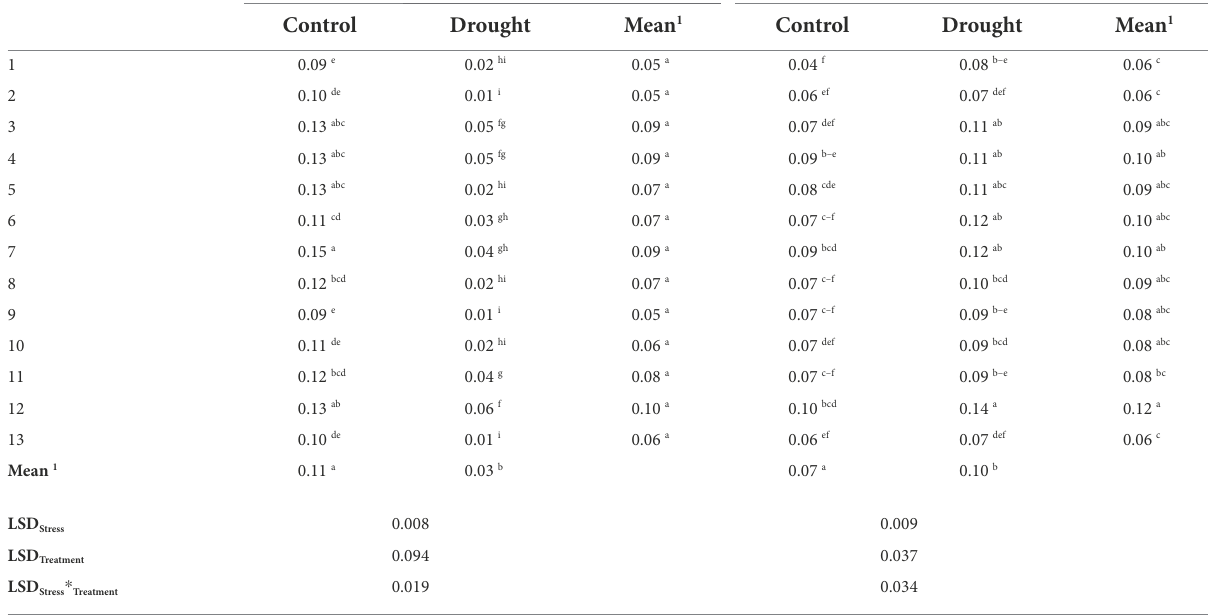
TABLE 6 The influence of the seed treatment and drought stress on stomatal conductance Gs (mol/m 2 × s) during drought stress and after regeneration. Treatment * During drought stress 2 After regeneration 2 Control Drought Mean 1